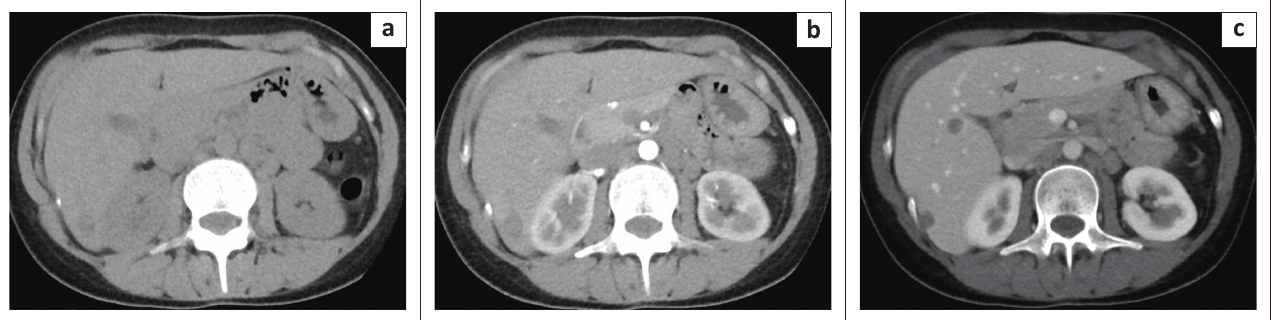
FIGURE 3: Axial CT images of the upper abdomen: (a) pre-contrast study; (b) arterial phase; (c) portal venous phase.